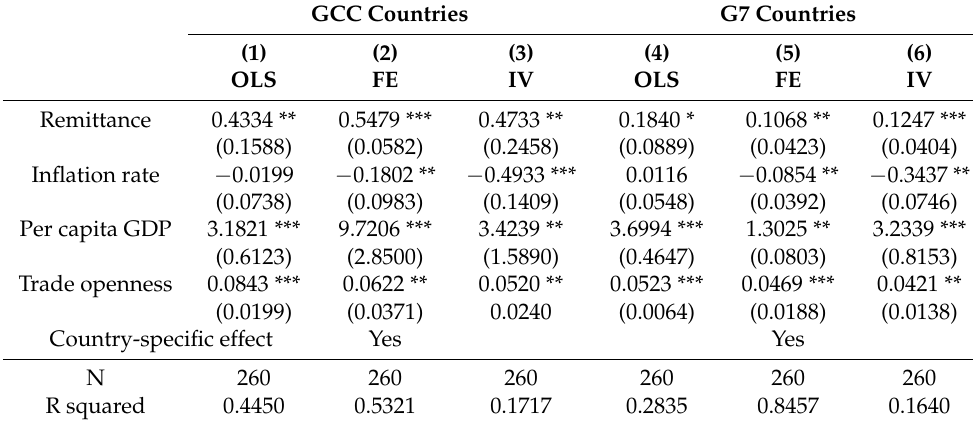
Table 8. Impact of remittance on commercial bank account